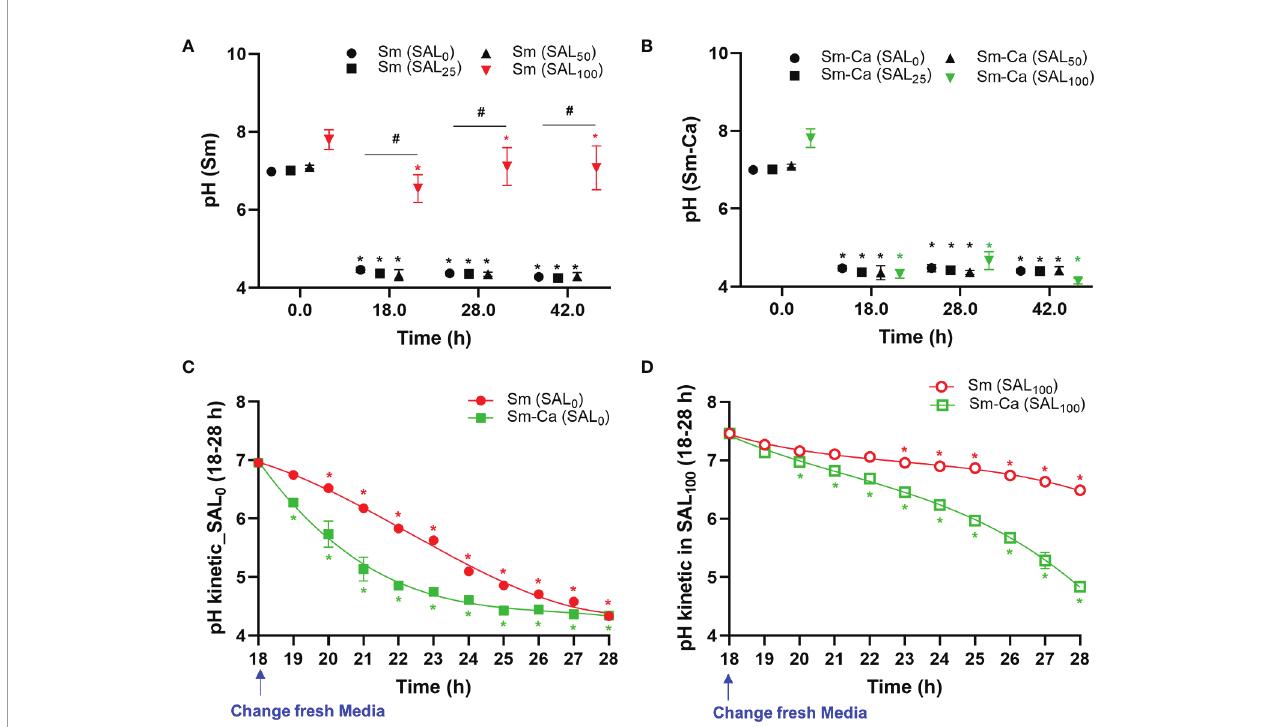
FIGURE 2 | Effect of human saliva on the pH of bio fi m supernatants in Sm and Sm-Ca bio fi lms. pH value at early (18 h), middle (28 h), and late (42 h) phases of Sm (A) and Sm-Ca (B) bio fi lms in different saliva ratios. Sm and Sm-Ca showed similar pH patterns under most culture conditions (SAL 0 , SAL 25 , and SAL 50 ), while Sm bio fi lm showed a completely different pH pattern when cultured under SAL 100 . Time-lapsed pH measurements of Sm and Sm-Ca bio fi lms in SAL 0 (C) and SAL 100 (D) during the middle phase (from 18 h to 28 h). Asterisk indicates that the p -values are signi fi cantly different from the pH of the starting point (ANOVA with Dunnett; * P < 0.05). Hash indicates that the p -values are signi fi cantly different among groups (Student ’ s t -test; # P <